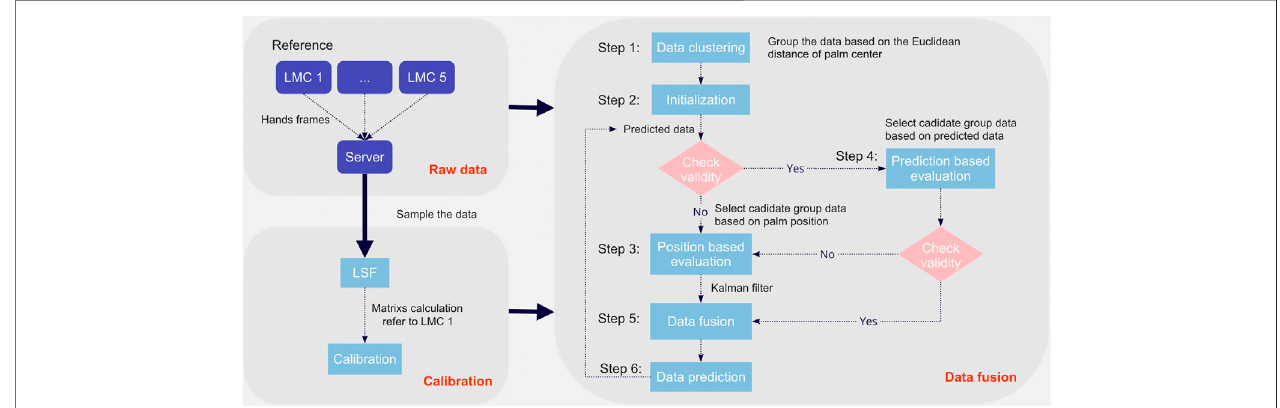
FIGURE 2 | Multi-LMC data fl ow